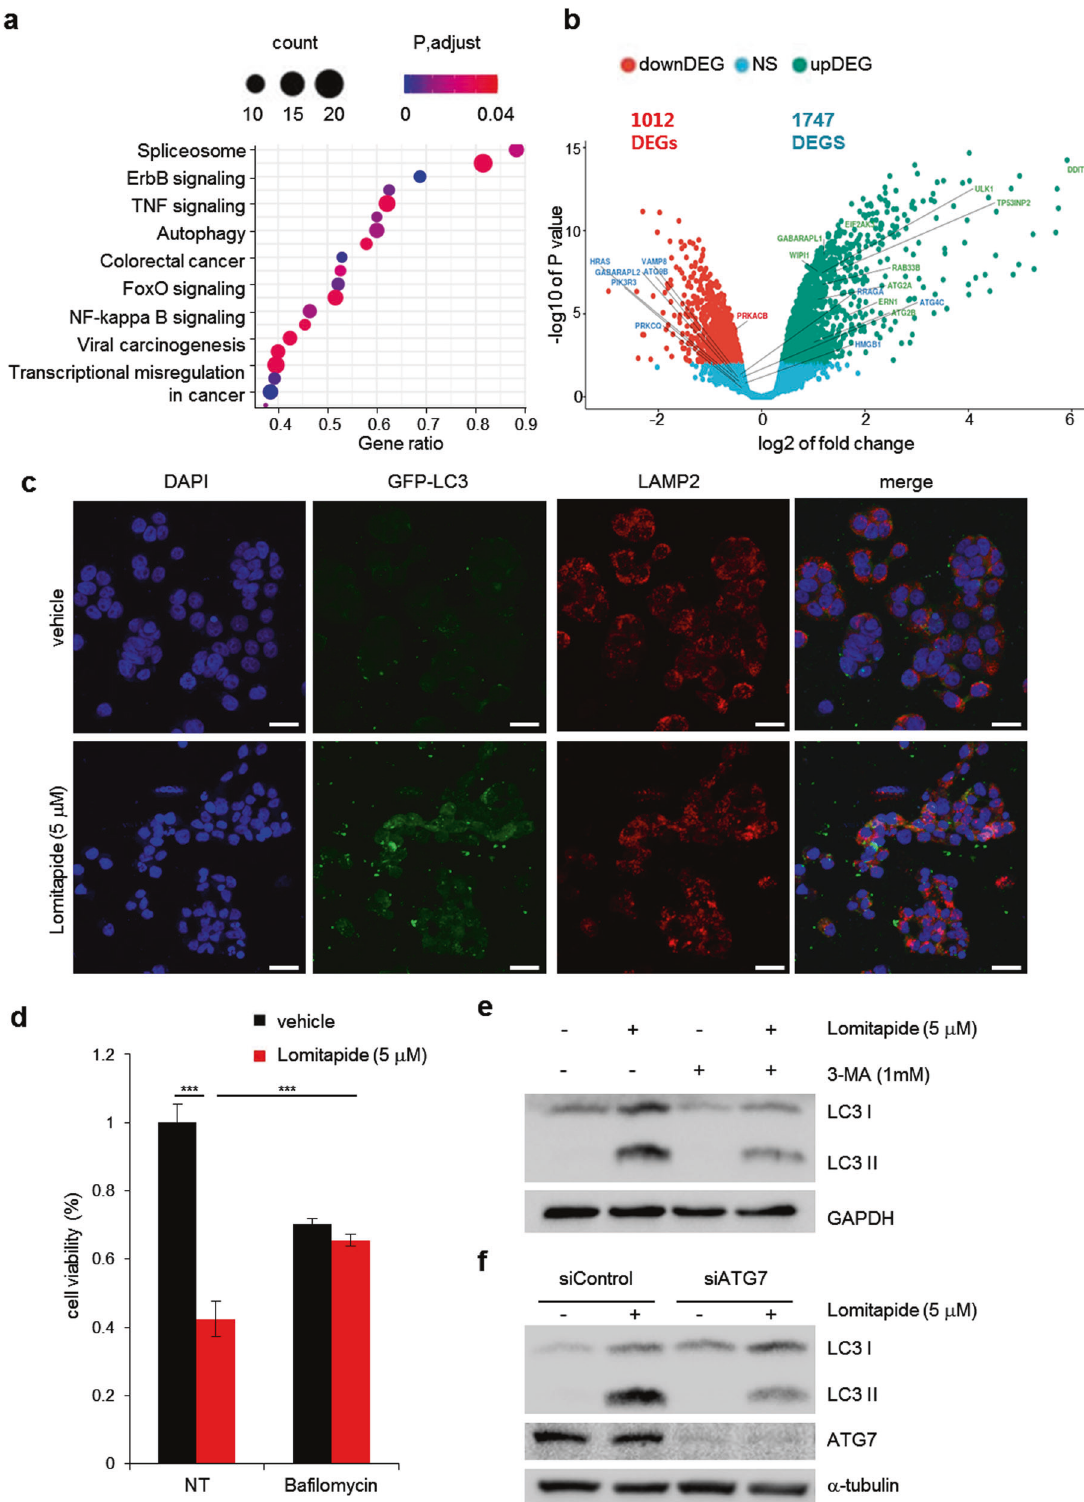
Fig. 3 Lomitapide leads to autophagic cancer cell death. a Signi fi cantly enriched pathways in lomitapide-treated HCT116 cells compared with vehicle-treated cells identi fi ed through KEEG analysis. b Volcano plot showing signi fi cant gene expression changes in response to lomitapide treatment in HCT116 cells. c HT29 cells were transfected with GFP-LC3 plasmid for 24 h, and treated with 5 μ M lomitapide for another 24 h. GFP-LC3 puncta was visualized by a confocal microscope. Scale bar: 20 μ m. d Cell viability was measured in HT29 cells treated with 5 μ M lomitapide in the absence or presence of 100 nM ba fi lomycin for 24 h. e HT29 cells were treated with 5 μ M lomitapide in the absence or presence of 1 mM 3-MA for 24 h. LC3 levels were measured by immunoblotting to assess autophagy induction. f si-control and siATG7 – transfected HT29 cells were treated with 5 μ M lomitapide for 24 h. LC3 levels were measured by immunoblotting to assess autophagy induction. Cell Death and Disease (2022)